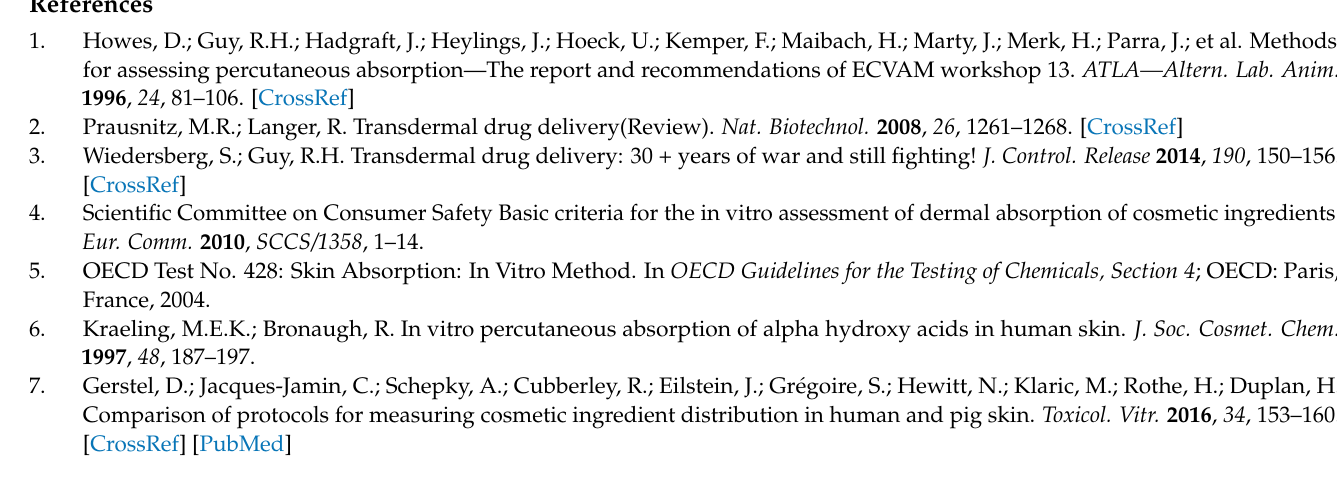
PAMPA, Figure S3: The permeability profile of PER dissolved in dimethylisosorbide using Skin- PAMPA, Figure S4: The permeability profile of PER dissolved in water/ethanol—80:20 ( w / w ) using Skin-PAMPA, Figure S5: The permeability profile of PER dissolved in water/dimethylisosorbide— 90:10 ( w / w ) using Skin-PAMPA, Figure S6: The permeability profile of PER dissolved in propylene glycol using Skin-PAMPA, Figure S7: The permeability profile of PER dissolved in water:propylene glycol—80:20 ( w / w ) using Skin-PAMPA, Figure S8: The permeability profile of PER dissolved in wa-ter/propylenglycol/ethanol—10:30:60 ( w / w / w ) using Skin-PAMPA, Figure S9: The permeability profile of PER dissolved in capric/caprylic triglyc-erides using Skin-PAMPA, Figure S10: The perme- ability profile of PER dissolved in octyl dodecanol using Skin-PAMPA, Figure S11: The permeability profile of PER dissolved in apricot kernel oil using Skin-PAMPA, Figure S12: The permeability profile of PER dissolved in corn oil using